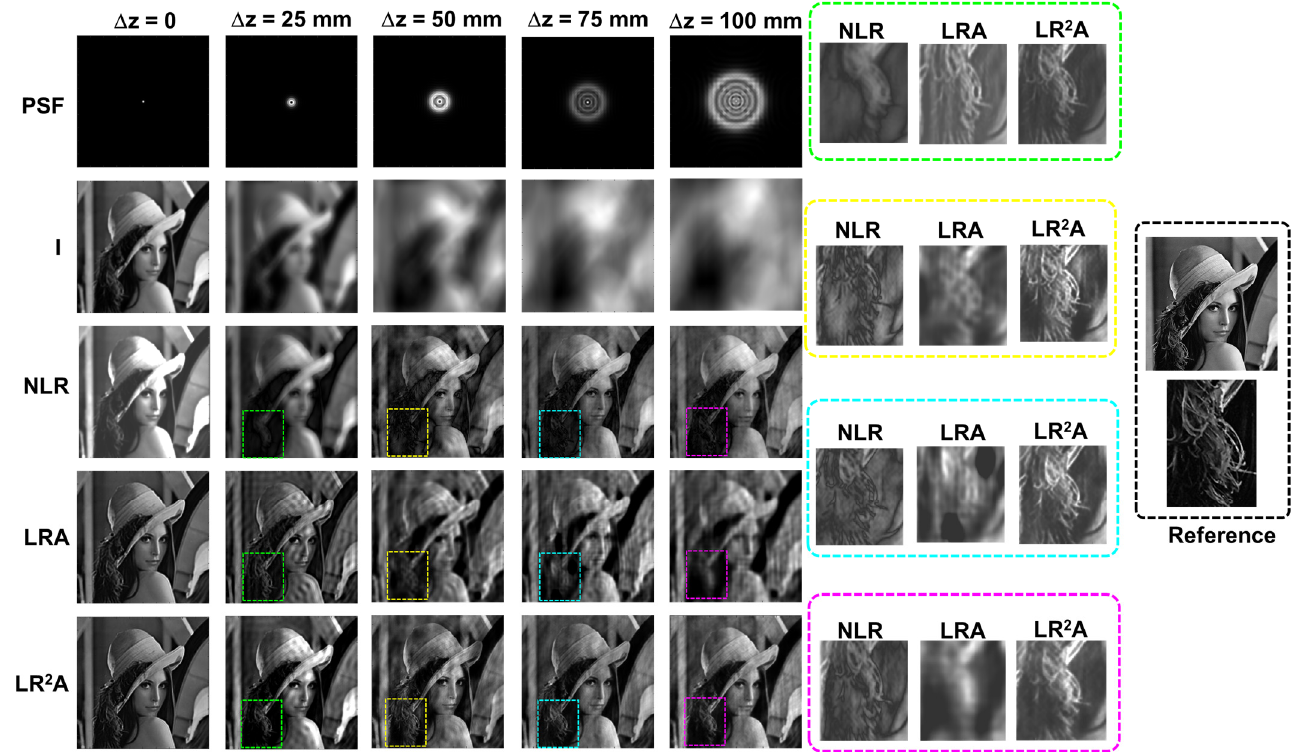
Figure 4. Deblurring results of NLR, LRA, and LR 2 A for different axial aberrations values ∆ z = 0, 25, 50, 75, and 100